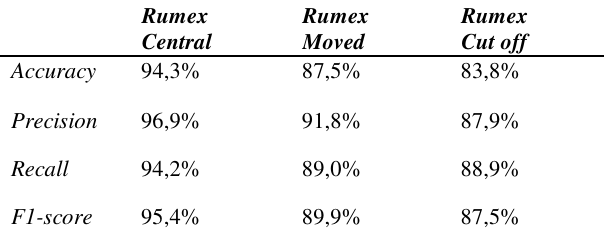
Table 3: Validation measures of the re-trained model The confusion matrix and validation measures for the final model, trained and tested on both moved and partly cut off Rumex plants, are shown in figure 15 and table 4.